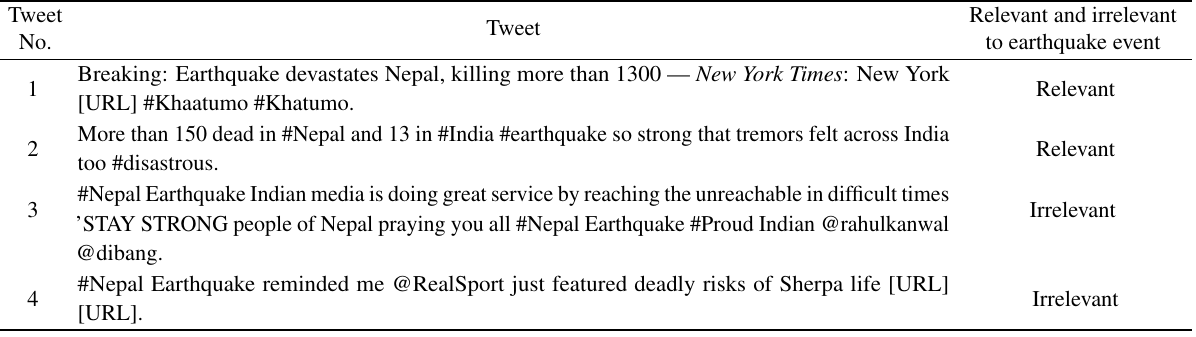
Table 1 Example tweets of relevant and irrelevant to earthquake